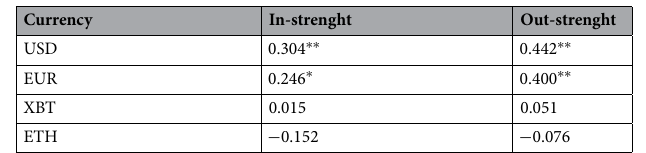
Table 1. Table shows the Spearman correlation ρ between the in strength and the out strength of a fiat with its “age” (that is, the number of windows in which it was active in the dataset). Two asterisks indicate that ρ is significant at p < 0.01 , one asterisk at p < 0.05 .